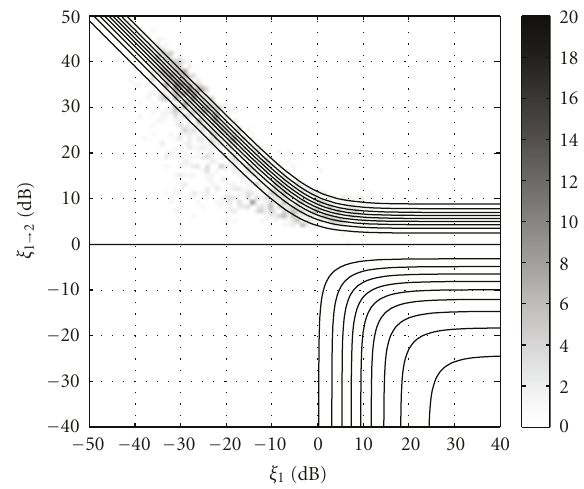
Figure 14: Missed detections of phoneme “t” ( λ = 0 . 1).